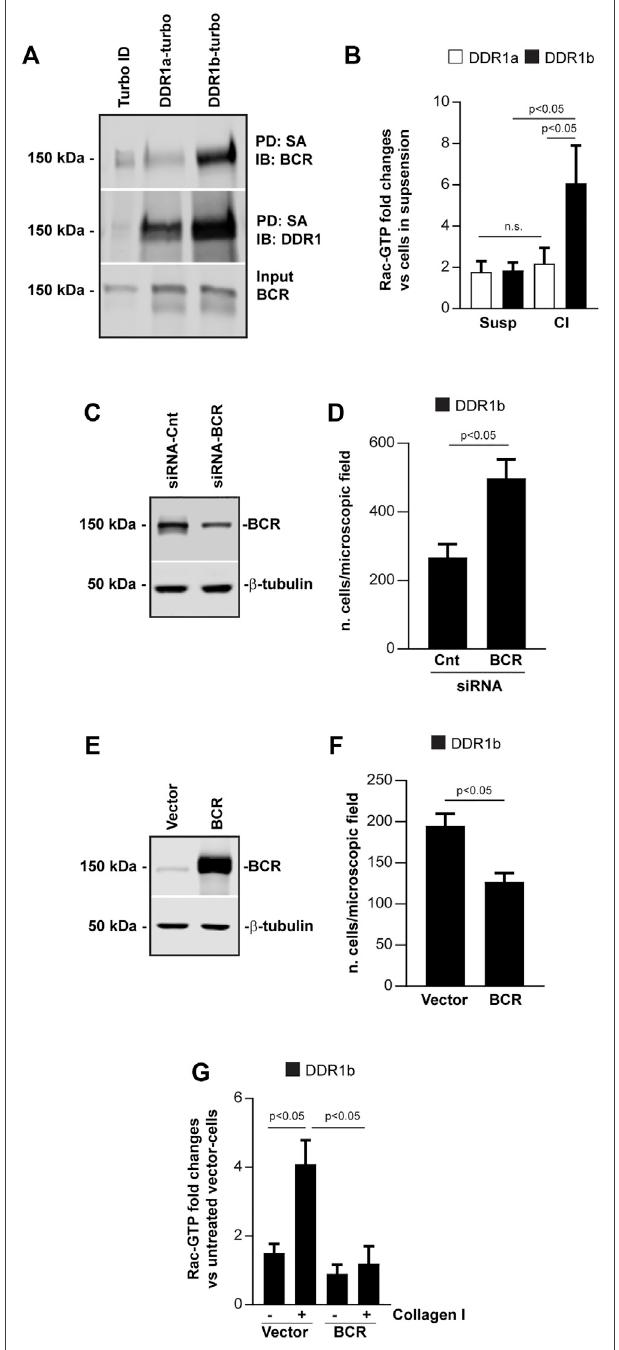
FIGURE 5 | are mean ± SEM of 3 independent experiments. Statistical analysis: one-way ANOVA followed by Tukey ’ s multiple comparison test. (C) Western blot analysis of cells transfected with Cnt siRNA or BCR siRNA. One representative experiment of 3 independent experiments is shown. (D) Mi- gration of DDR1b cells transfected with Cnt siRNA or BCR siRNA toward collagen I (20 μ g/ml). Values are the mean ± SEM of 3 independent exper- iments with 7 fi elds/microscopic fi eld counted . (E) Western blot analysis of cells transfected with BCR or empty vector. One representative experiment of 3 independent experiments is shown. (F) Migration of DDR1b cell transfected with BCR or empty vector towards collagen I (20 μ g/ml). Values are the mean ± SEM of 3 independent experiments with 7 fi elds/microscopic fi eld counted.Statisticalanalysisfor (D,F): unpairedtwo-tail t-test. (G) DDR1b cells transfected with BCR or empty vector were left in suspension or plated on collagenIfor30 min, lysedand thenanalyzed forthelevelsofactive Racusing a G-LISA assay as described above. Values represent fold increase relative to cells transfected with empty vector with the lowest levels of active Rac left in suspension assigned a value of 1. Values are mean ± SEM of 3 independent experiments. Statistical analysis: one-way ANOVA followed by Tukey ’ s multiple comparison